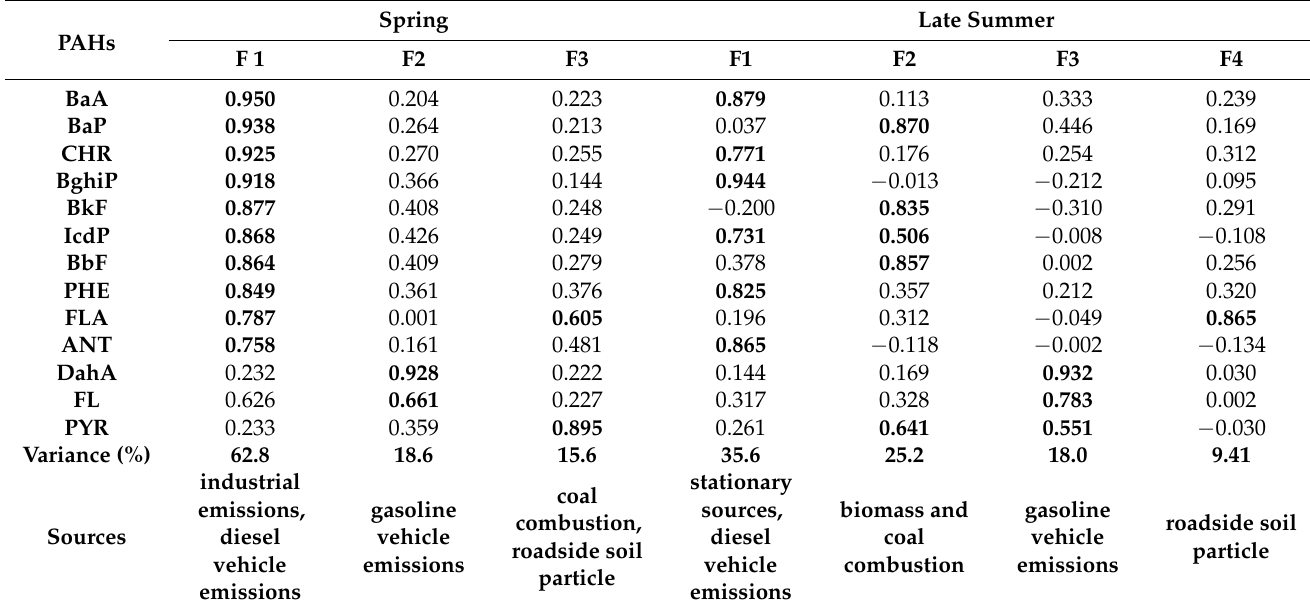
Table 4. PCA loading factors for PAH compounds in fine particles of PM 1.1 during the spring and late summer sampling